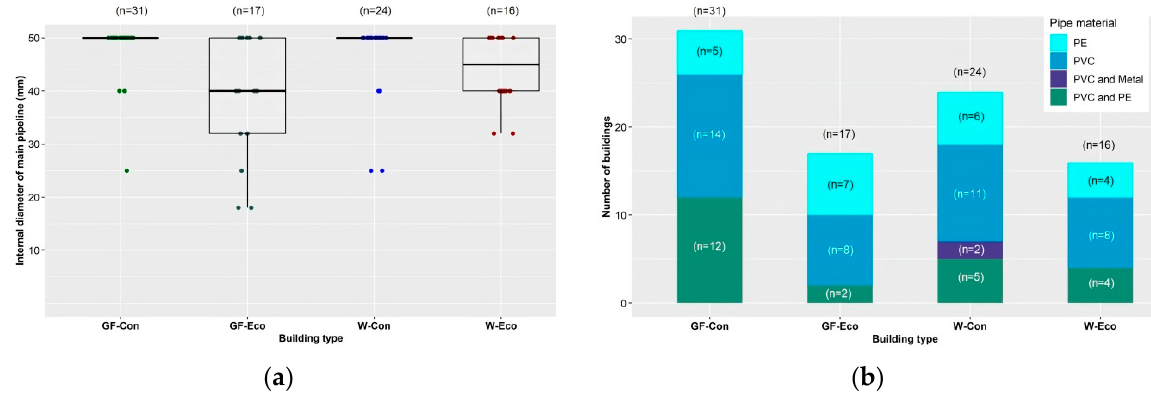
Figure 3. By building type: ( a ) internal diameter of main pipeline (mm), (GF-Con: Q1: 25, Median: 50, Mean: 48.6, Q3: 50; GF-Eco: Q1: 32, Median: 40, Mean: 39.1, Q3: 50; W-Con: Q1: 50, Median: 50, Mean: 47, Q3: 50; W-Eco: Q1: 40, Median: 45, Mean: 44, Q3: 50); ( b ) composition of main pipeline. GF-Con = conventional grower/finisher buildings (solid/slatted/mesh floored pens), GF-Eco = grower/finisher eco-shelters (straw-floored pens), W-Con = conventional weaner buildings (solid/slatted/mesh floored pens), W-Eco = weaner eco-shelters (straw-floored pens). PE = polyethylene, PVC = polyvinylchloride.